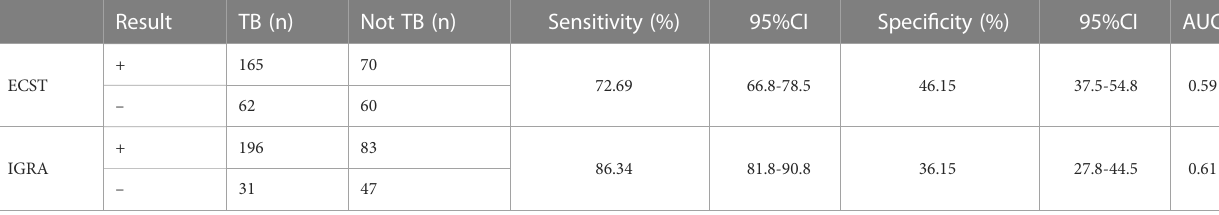
TABLE 2 Comparison of the accuracy of the ECST and IGRA tests in patients with bacteriological diagnosed tuberculosis.